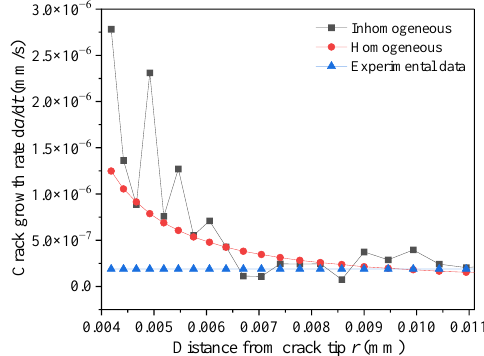
Figure 17. Comparison of SCC growth rate with experimental